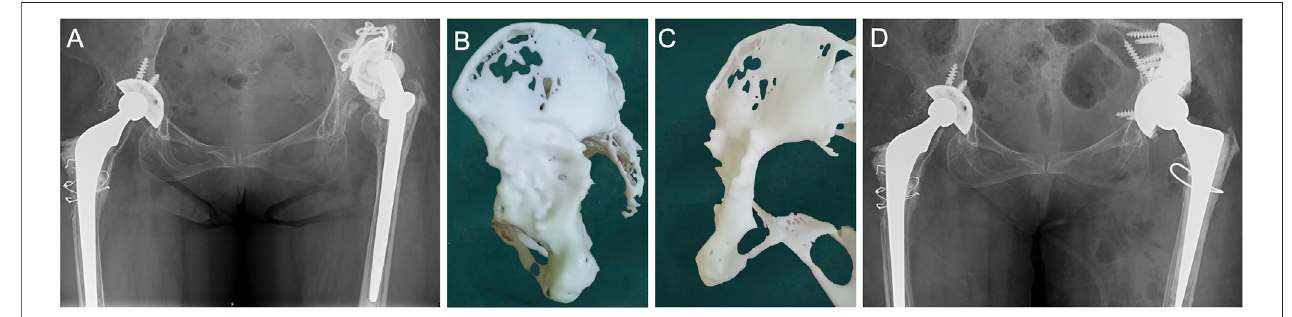
FIGURE 4 | A representative patient receiving this combined therapy. (A) Preoperative AP pelvic x-ray of this patient. (B,C) Rapid prototype reconstruction of this patient ’ s acetabulum. (D) Postoperative AP pelvic x-ray taken 3 years after revision surgery. Reproduced with permission from authors (Zhang et al., 2022).